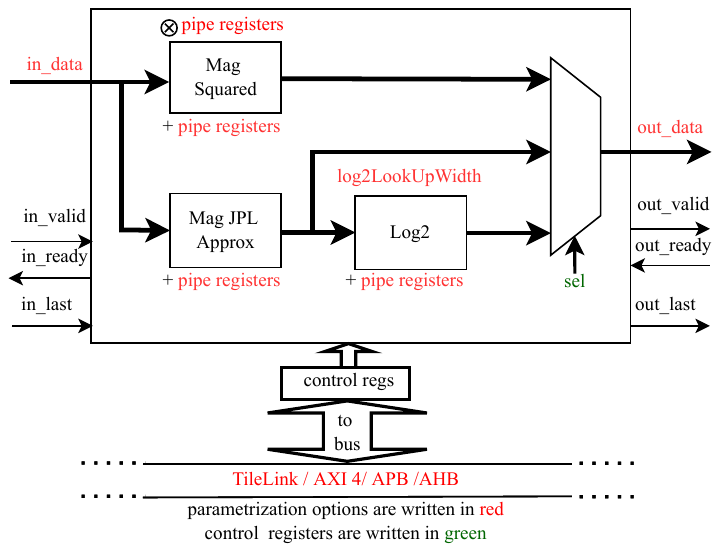
Figure 10. Interface of the simplified log-magnitude multiplexer Chisel3 generator showing in- put/output signals as well as control